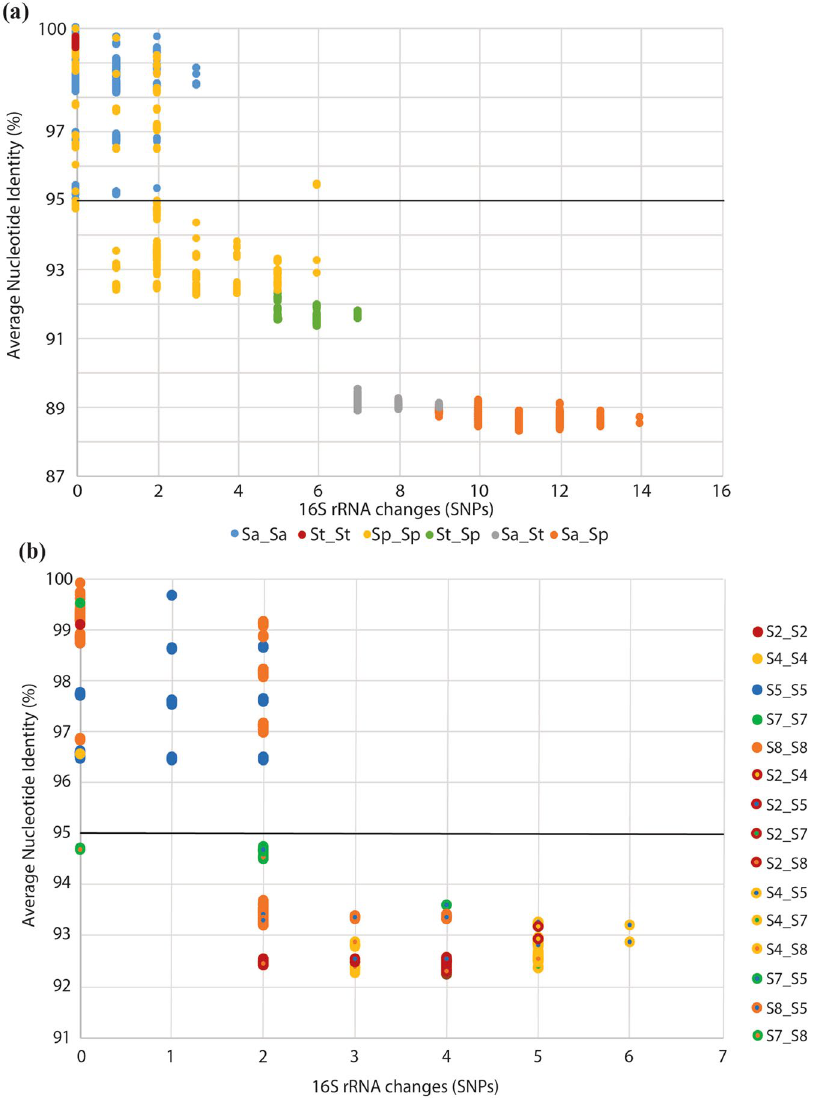
Figure 6. Relationships between 16S rRNA diversity and Average Nucleotide Identity (ANI). The black line indicates 95% ANI. ( a ) Inter- and intraclade comparisons among the three major lineages represented by S . tropica (St), S . arenicola (Sa), S . pacifica (Sp). ( b ) Inter- and intraclade comparisons among the S . pacifica clades (2–8) as identified in Figs 4 and